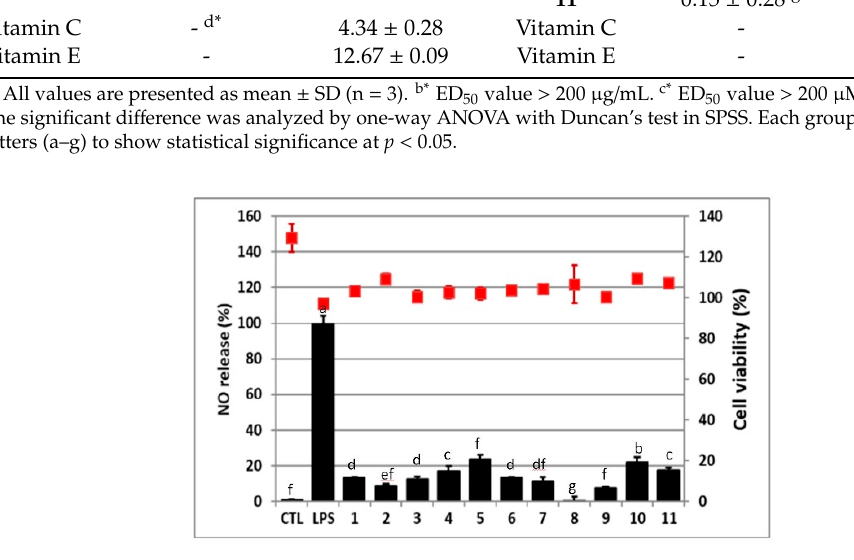
Figure 7. Anti-NO production activities (black column) and cell viability (red square) of the isolated compounds 1 – 11 (20 µ g / mL). Cells were treated with LPS (1 µ g / mL) or in combination with tested isolates (20 µ g / mL) for 24 h. All values are presented as mean ± SD (n = 3). CTL: Control group. LPS: Treatment with LPS. The significant di ff erence was analyzed by one-way ANOVA with Duncan’s test in SPSS. Each group used di ff erent letters (a–f) to show statistical significances ( p < 0.05) in anti-NO activity. Table 5. Antioxidant activity of DPPH scavenging a* for the extract, fractions, and the isolates 1 – 11 .